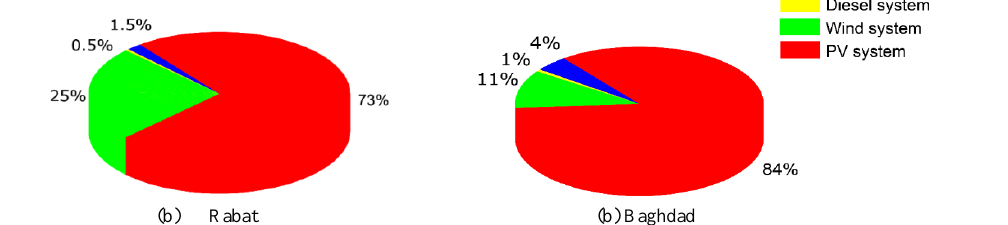
Figure 9. Contribution of system components to energy